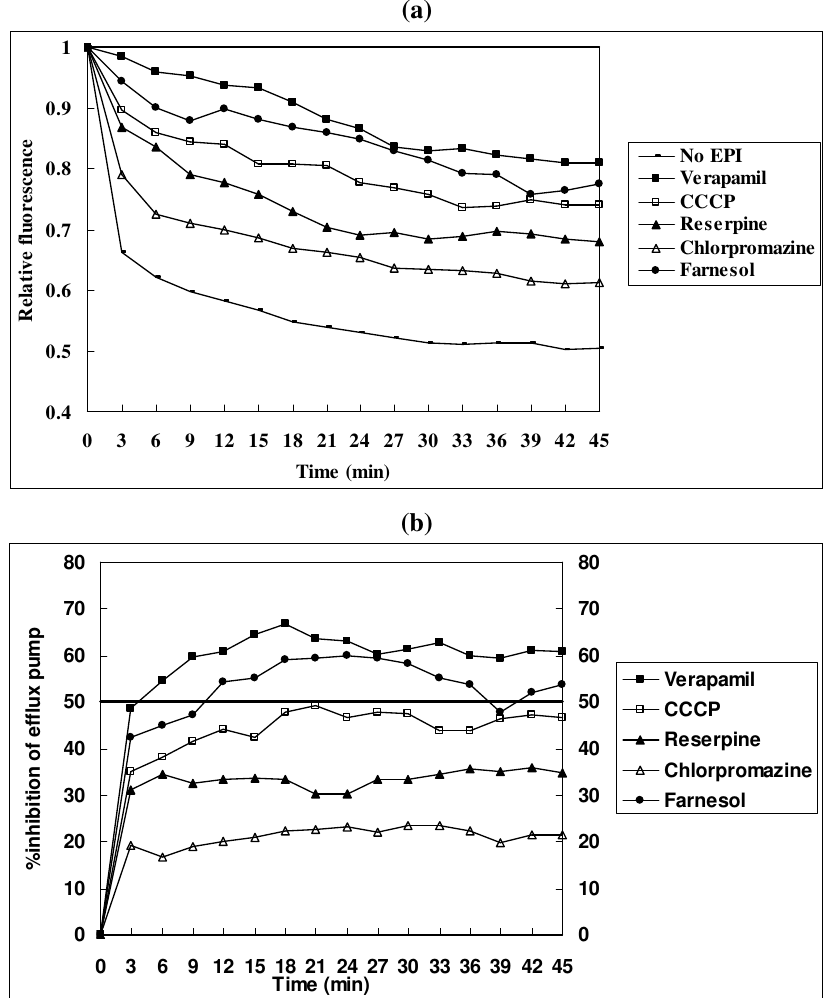
Figure 3. Effect of EPIs on the efflux of EtBr in M. smegmatis mc 2 155 cells (a) and the percentage inhibition of efflux pump by EPIs (b). The assay was conducted at 25 °C with glucose, after loading the mycobacteria with EtBr at 4 µ g/mL in the presence of verapamil at half its MIC. Concentrations of reserpine, chlorpromazine, verapamil, CCCP and farnesol are at half of their MICs (Table 1). The horizontal line indicates 50% efflux inhibition in Figure 3